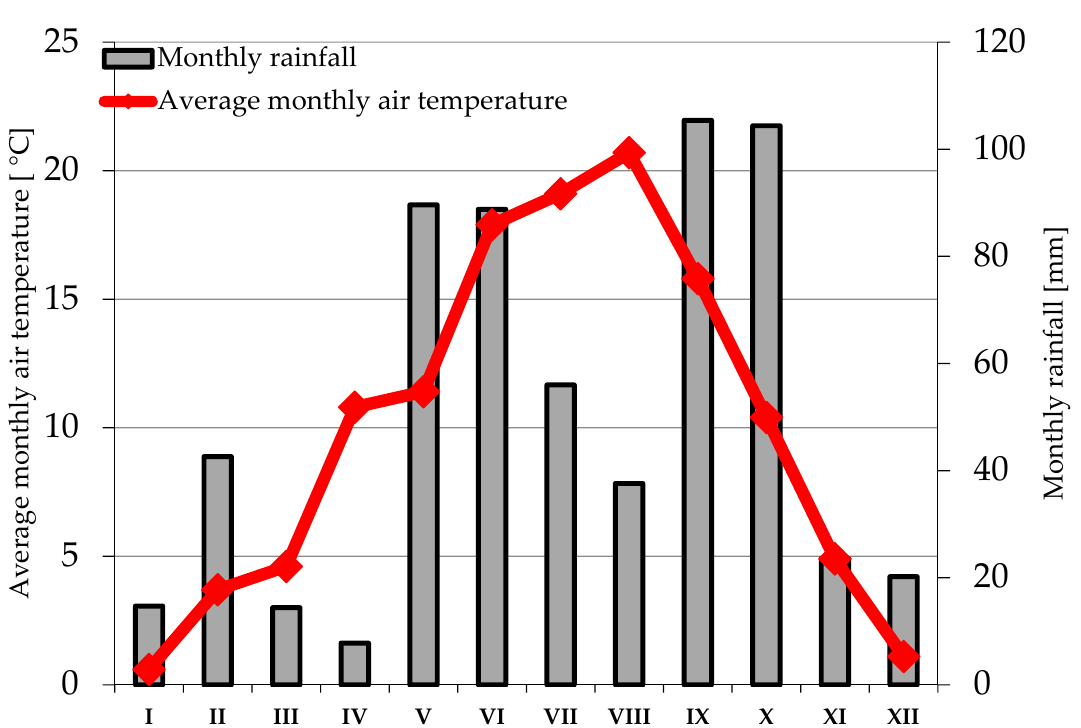
Figure 1. Rainfall and average air temperature at the Prusy Experimental Station of the Agricultural University of Krakow in the years 2020.